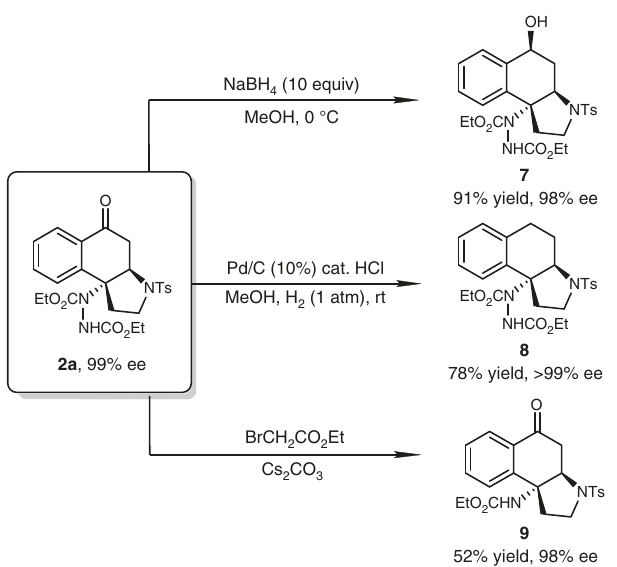
Fig. 6 Transformations of 2a . Reaction conditions for synthesis of 7 : 2a (0.2 mmol), NaBH 4 (2.0mmol) in MeOH (4mL) at 0°C. Reaction conditions for synthesis of 8 : 2a (0.2mmol), Pd/C (10%, 50mg), HCl (conc. 20 μ L) in MeOH (4mL) under H 2 (1 atm) at room temperature. Reaction conditions for synthesis of 9 : 2a (0.2mmol), Cs 2 CO 3 (0.26mmol), BrCH 2 CO 2 Et (0.22mmol) in